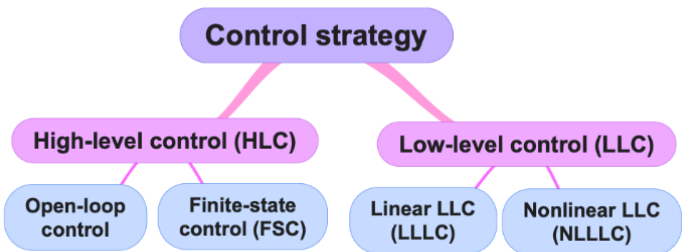
Figure 1. Hierarchical levels of FES control strategies and their subdivisions.